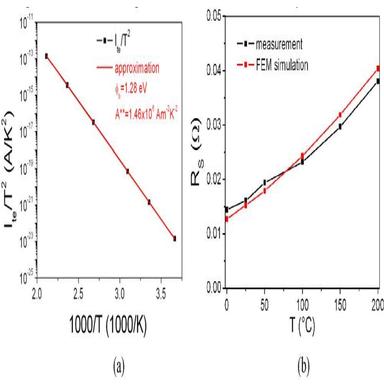
(a) Activation energy plot of the thermionic emission current extracted by Eq. (b) Temperature dependence of series resistance RS of power SiC Schottky diode.